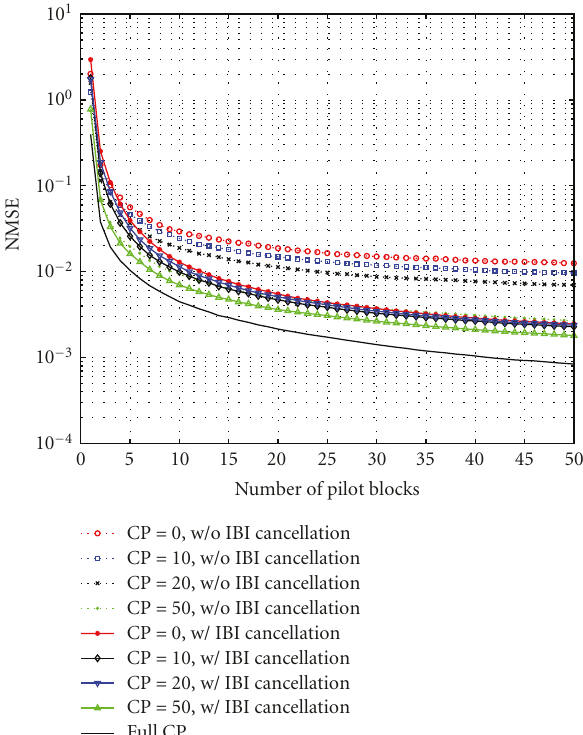
Figure 2: Performance of FD channel estimation with and without IBI cancellation, number of pulse repetition = 4 block size = 160 symbols (640 chips), max. CM4 UWB channel, channel length = 360, and taps SNR = 20dB. Figure 3: Receiver performance over di